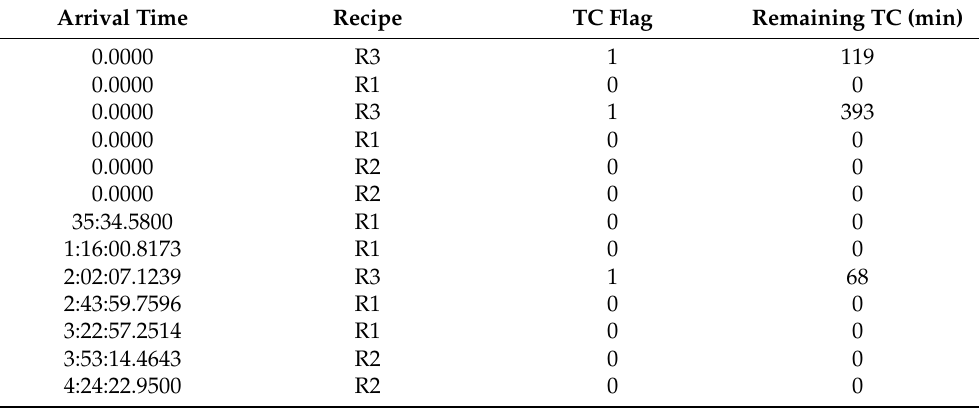
Table 3. Arrival